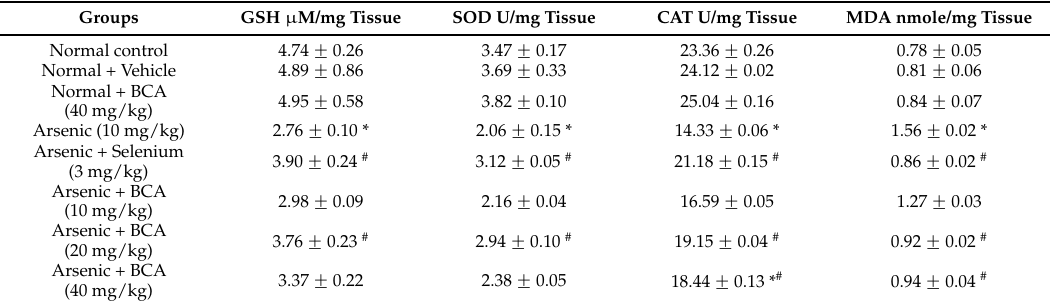
Table 2. Oxidative stress markers in the liver of normal control and experimental rats. Groups